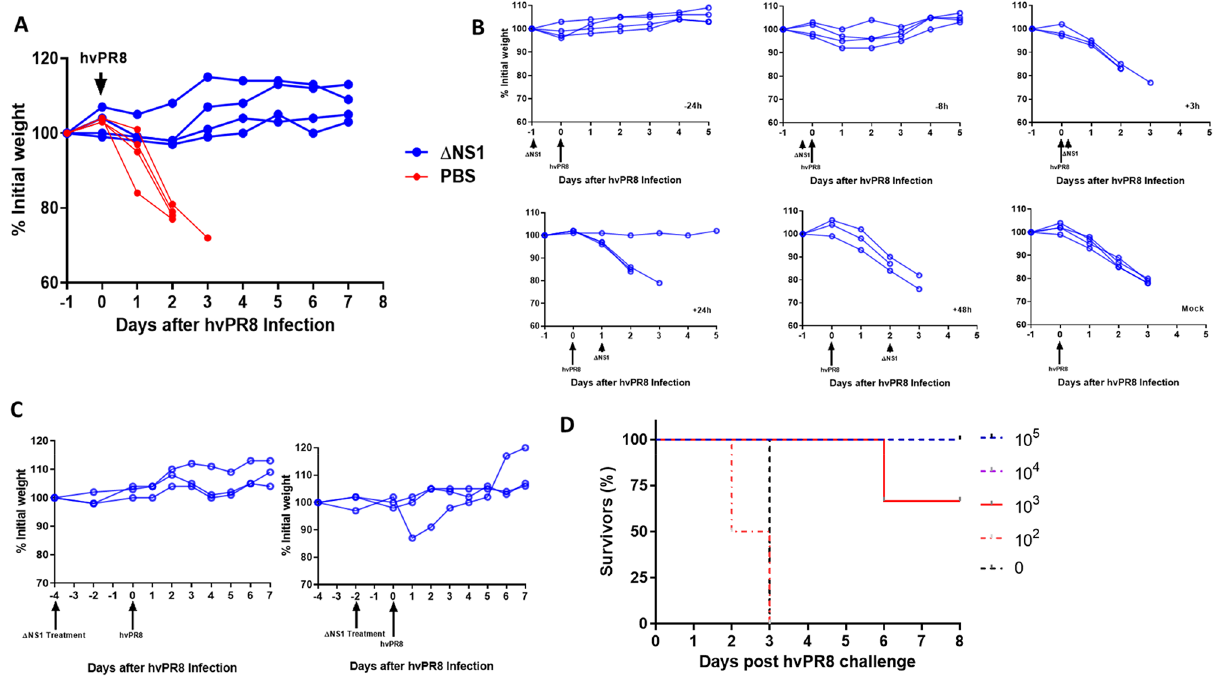
Figure 2. A single dose of ΔNS1 virus protects A2G mice against lethal infection by highly virulent hvPR8 influenza virus when given prior to virus challenge. ( A ) Treatment with ΔNS1 virus protects A2G mice against lethal infection by highly virulent hvPR8 influenza virus. Eight 6-week old A2G mice were intranasally infected with 5 × 10 6 PFU of highly virulent A/PR/8/34 (hvPR8) influenza virus. Half of the mice received a total of five intranasal treatments with 5 × 10 5 PFU of ΔNS1 virus at the following times with respect to the hvPR8 infection: − 24 h, − 8 h, + 3 h, + 24 h ad 48 h. The remaining four mice were treated with PBS and the bodyweight changes and survival was monitored. ( B ) A single dose of ΔNS1 virus protects A2G mice against lethal infection by highly virulent hvPR8 influenza virus when given prior to hvPR8 virus challenge. Groups of three A2G mice each were mock-treated or treated intranasally with 5 × 10 5 PFU of ΔNS1 at time points − 24 h, − 8 h, + 3 h, + 24 h, + 48 h relative to the intranasal infection by 5 × 10 6 hvPR8 influenza virus. ( C ) A single dose of ΔNS1 virus protects A2G mice against lethal infection by highly virulent hvPR8 influenza virus when given 2 and 4 days prior to hvPR8 virus administration Groups of three A2G mice were intranasally treated with 5 × 10 5 PFU of ΔNS1 virus 4 days or 2 days before infection by 5 × 10 6 hvPR8 influenza virus. Bodyweight changes and survival was monitored. All data points are from individual mice. ( D ) Determination of the minimal effective therapeutic dose of ΔNS1 to prevent lethal hvPR8 virus infection in A2G mice. Groups of three A2G mice were intranasally infected with 10 5 , 10 4 or 10 3 PFU ΔNS1 influenza virus. Additionally, groups of two A2G mice were intranasally challenged with 10 2 of ΔNS1 virus or PBS. 24 h post inoculation, mice were challenged with by 5 × 10 6 hvPR8 influenza virus. The percentage of mice surviving the challenge is